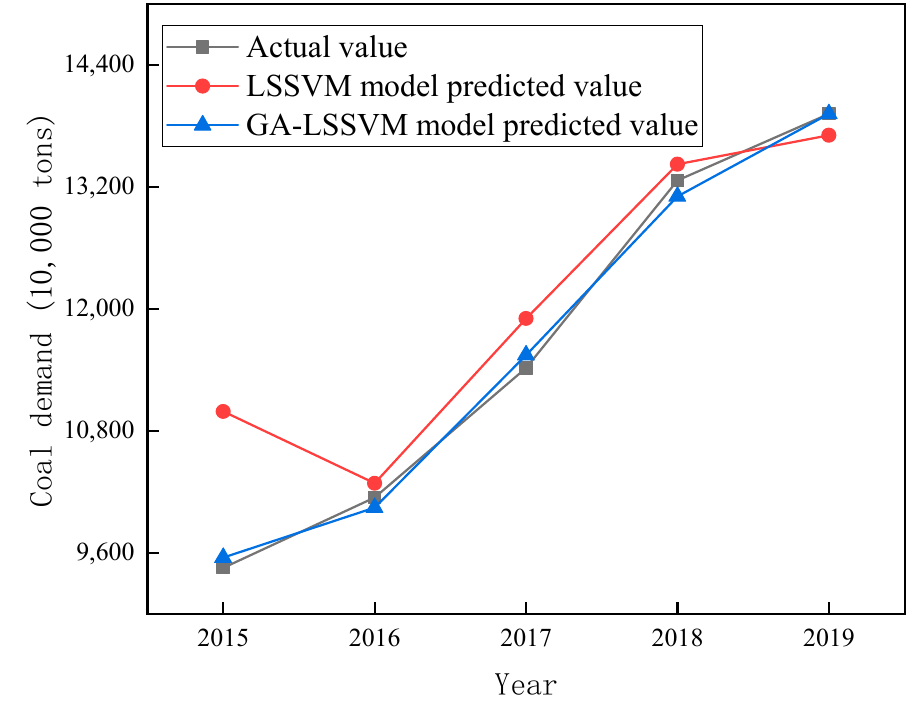
Figure 4. Comparison of predicted and actual results. Table 2. Model error analysis results.